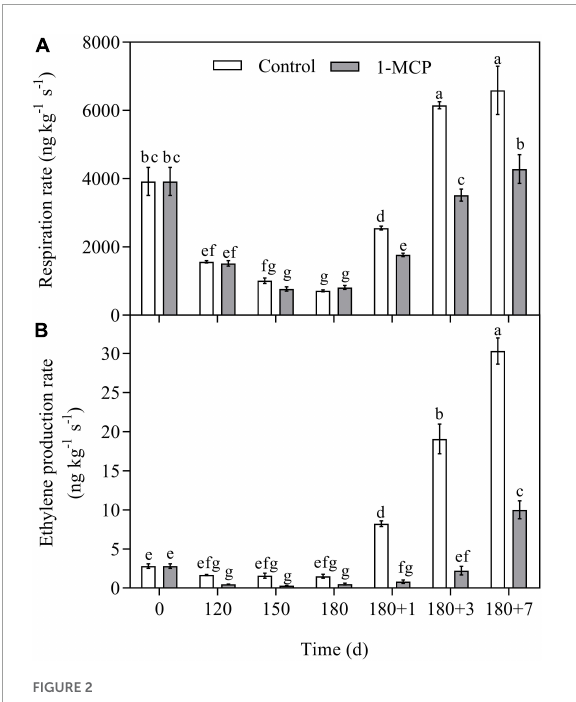
FIGURE2 Effect of 1-MCP on respiration (A) and ethylene production (B) of “Yali” pear during cold storage and shelf life. 180 + 1, 180 + 3, 180 + 7 indicated Days 1, 3, 7 at shelf life after 180 days of cold storage, respectively. All data are expressed as means ± standard errors of triplicate samples. Different letters indicate significant differences ( P < 0.05) by Duncan’s multiple comparison